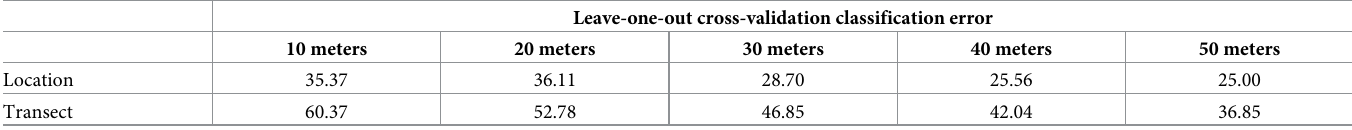
Table 5. Classification error of leave-one-out cross-validation of CAP analyses (Bray-Curtis, fourth-root transformed, eight PCO axes ( m )). CAP analyses were per- formed for different transect lengths (10, 20, 30, 40 and 50 meters) and different grouping factors (Location and